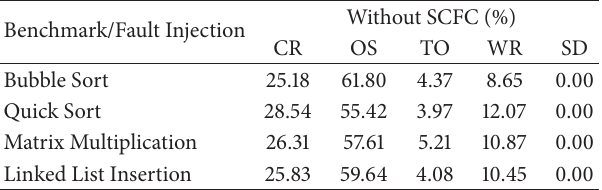
Table 1: Fault injection results on Memory Manager without SCFC.